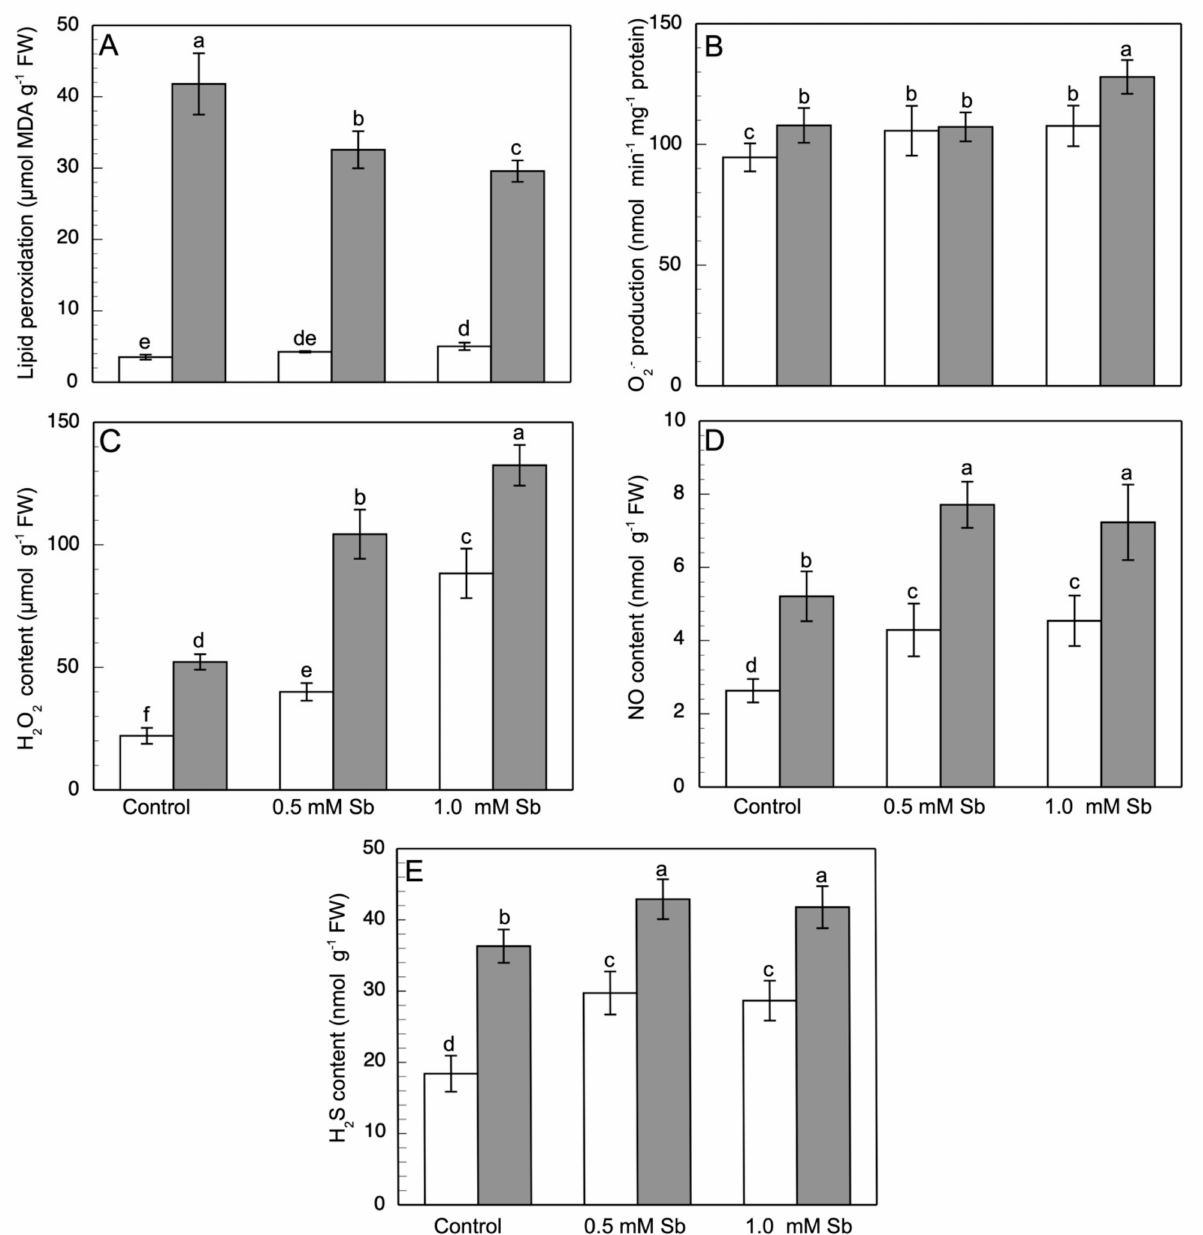
Figure 2. Effect of Sb on the lipid peroxidation ( A ), O 2 − production ( B ), and H 2 O 2 ( C ), NO ( D ) and H 2 S ( E ) content in roots (white) and leaves (gray) of D. viscosa . The data are from 10 independent experiments, each carried out in triplicate (different letters indicate significant differences at p < 0.05, Mann–Whitney